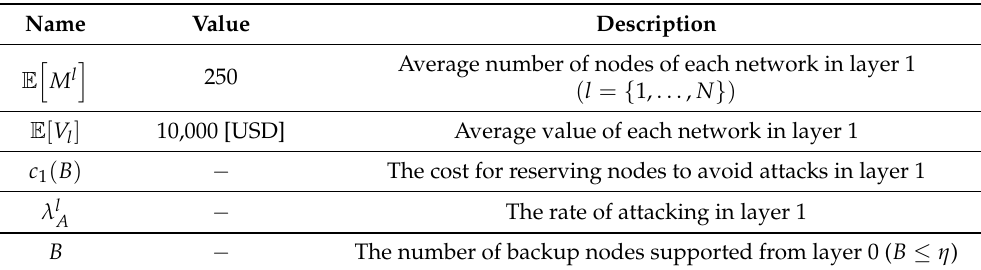
Table 1. Initial conditions for layer 1.